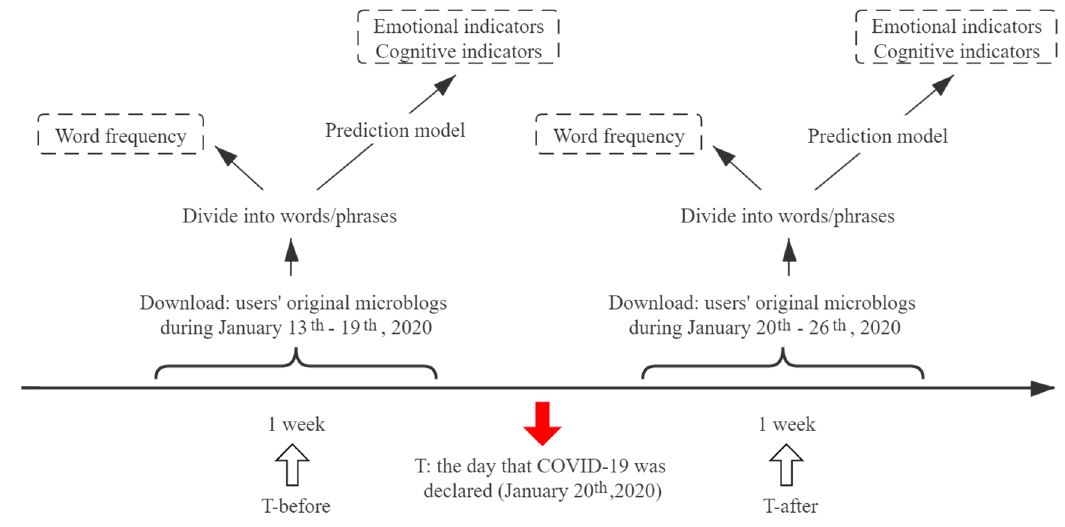
Figure 1. Procedures of feature extraction from online Weibo data and psychological indicator predicted by dynamic features.